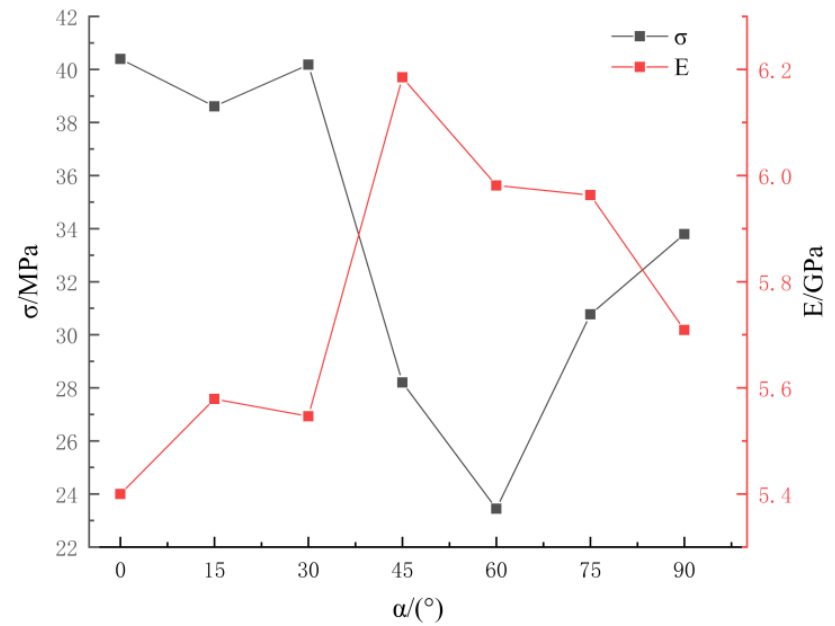
Figure 4. Compressive strength and elastic modulus of coal and rock at different azimuth angles.